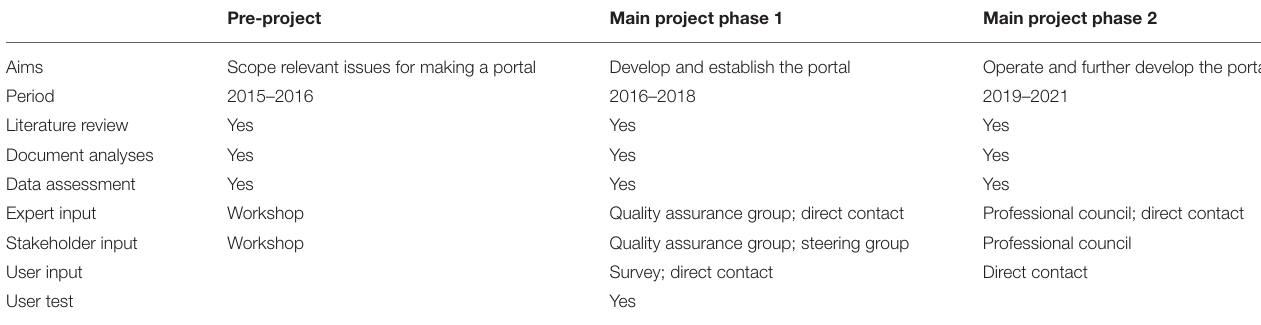
TABLE 1 | Main characteristics of pre-project and main project’s phases 1 and